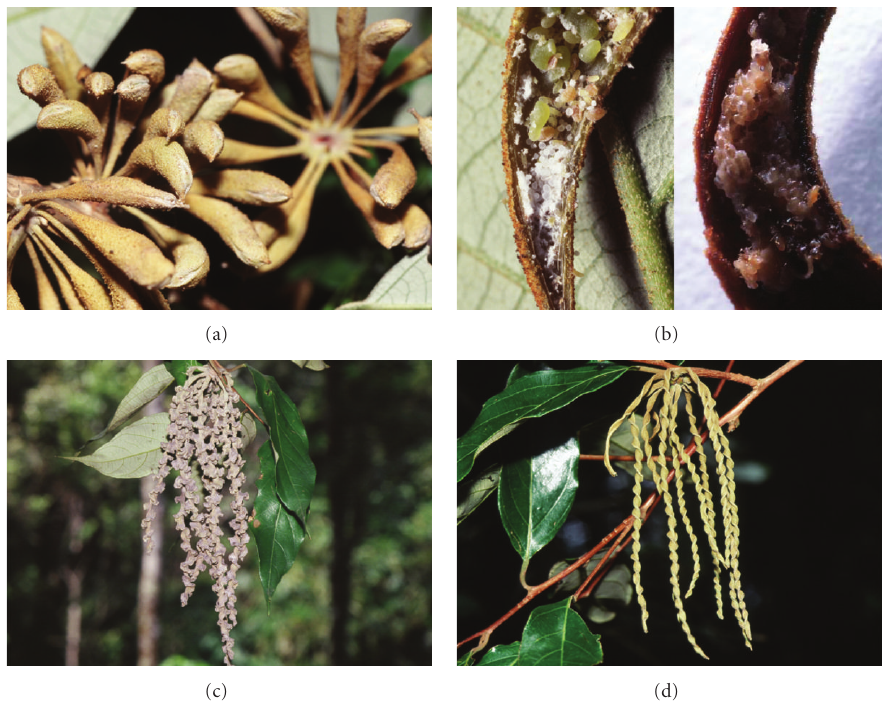
Figure 6: (a) Three galls of Astegopteryx spinocephala on Styrax benzoides (Chiang Mai, Thailand; 6 April 2000). (b) Cut subgalls of A. spinocephala (Chiang Mai; 6 April 2000): a live subgall (left) showing the inside, and another subgall after being submerged in alcohol (right) showing many eggs in its basal part (in the left photo, eggs are hard to see because they are covered with wax). (c) A mature gall of Ceratoglyphina roepkei on Styrax paralleloneurus (Bandar Baru, Sumatra; 24 February 1994). (d) A young gall of C. roepkei on S. paralleloneurus (Bandar Baru; 24 August